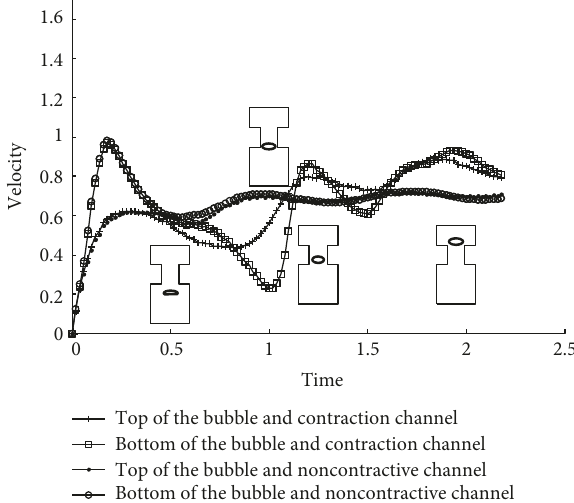
0.5 Figure 5: Aspect ratio of the bubbles with di ff erent contractive ratios (Re =28.2, Eo=16, and Mo =0.01).